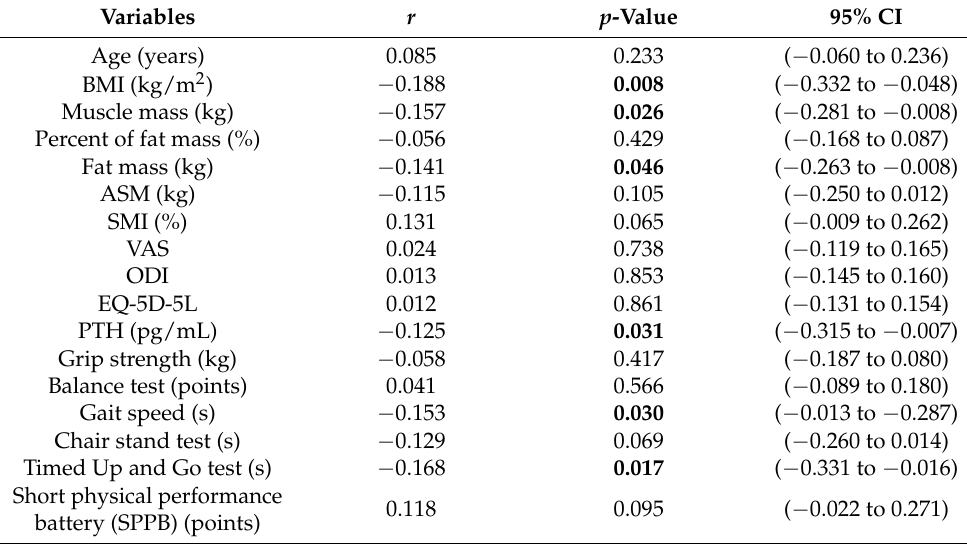
Table 2. Correlations between serum 25(OH)D and different parameters (n =